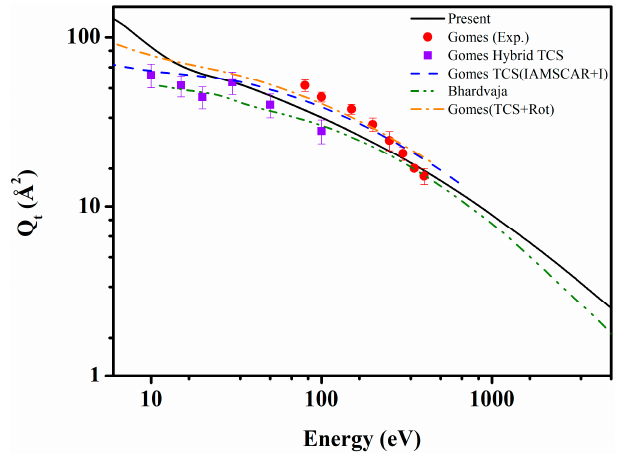
Figure 5. Total cross-section butan-1-ol: black solid line shows present results, red circles are experimental results by Gomes et al., purple squares are ‘hybrid TCS’ by Gomes et al., blue dashed lines are calculated values by Gomes et al., green dash-dot-dot line is from Bhardvaja et al. and orange dash-dot-dash line shows TCS + rotational from Gomes et al.